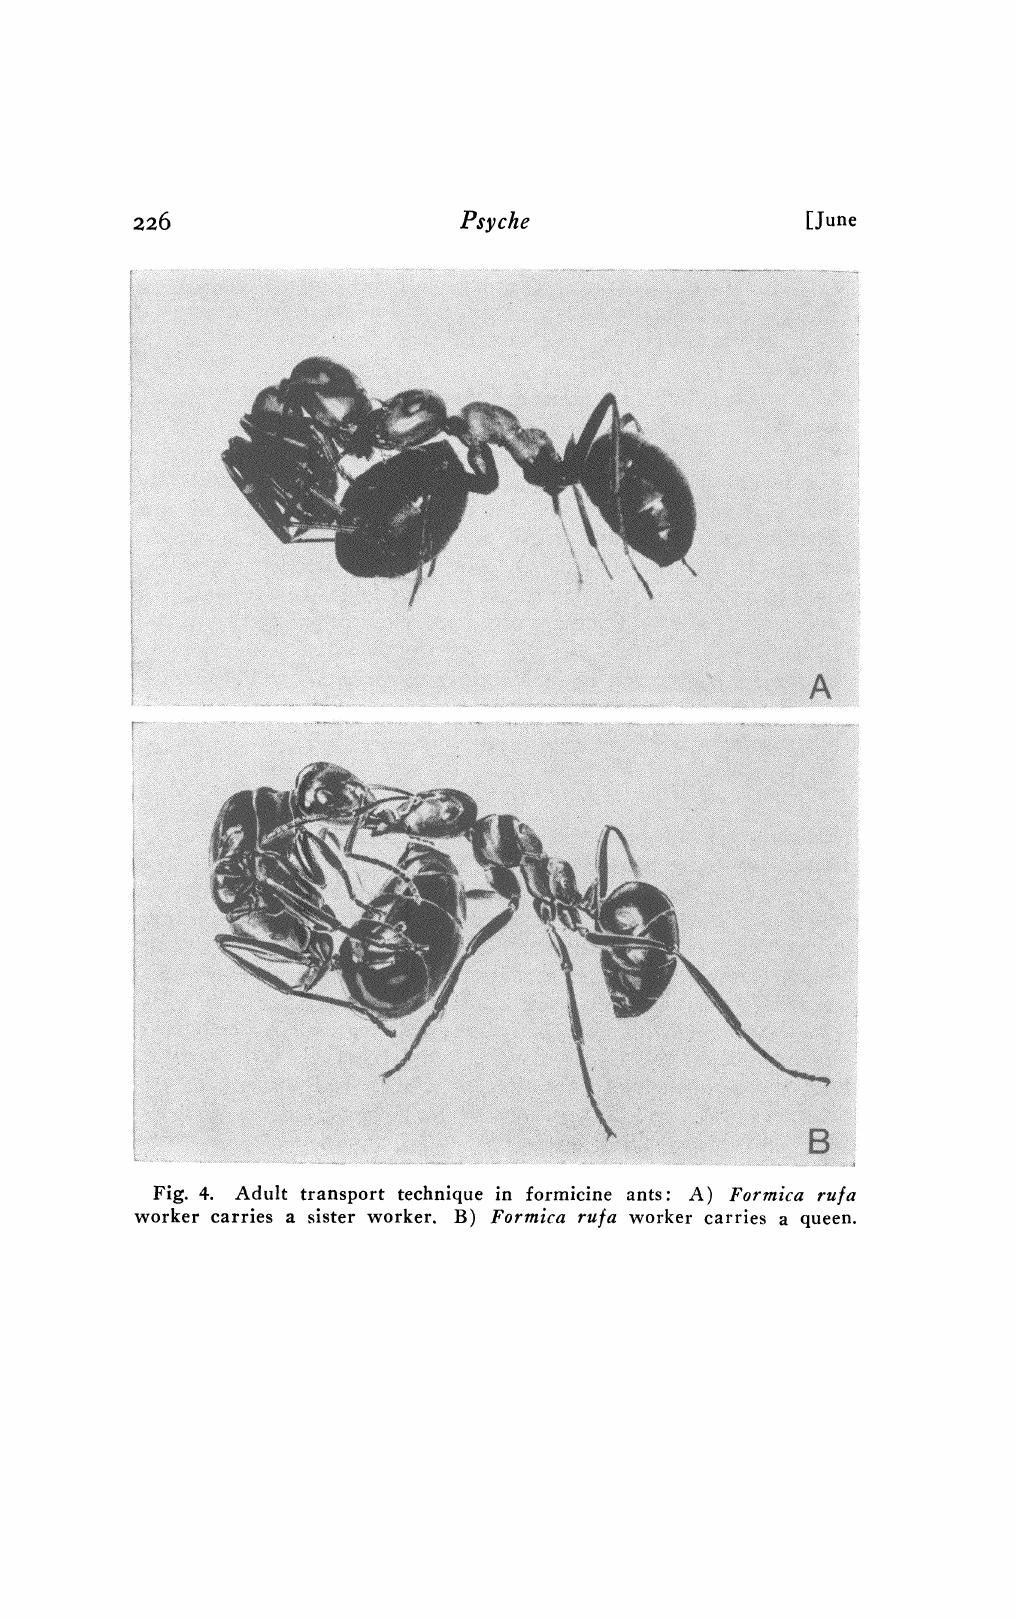
Fig. 4. Adult transport technique in ormicine ants" A) Formica ru]a worker carries a sister worker. B) Formica